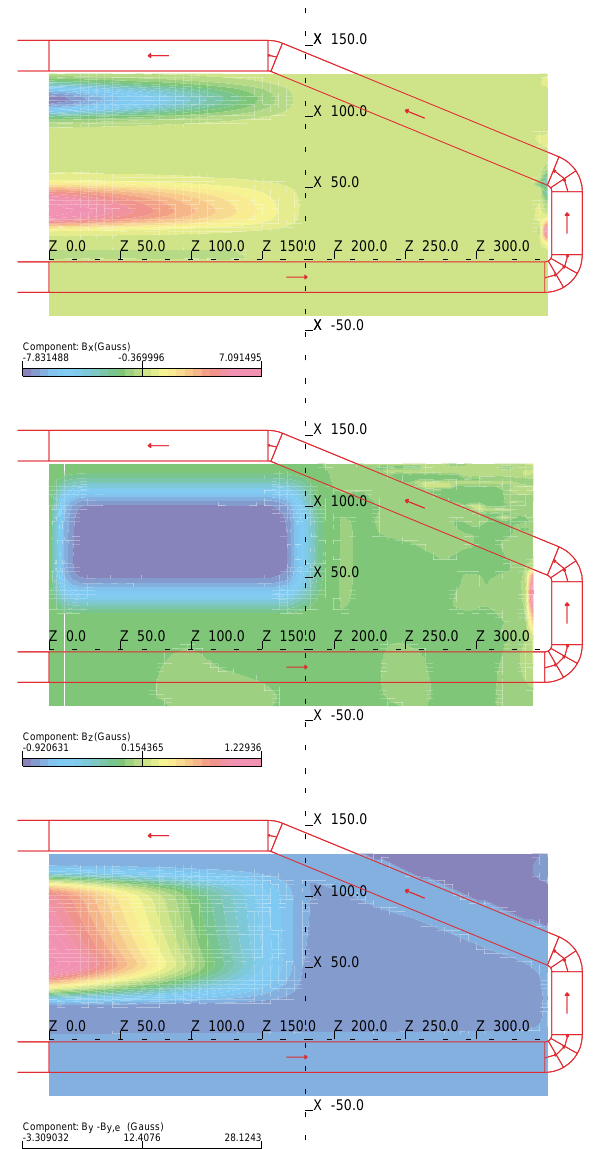
FIG. 2. (Color) Simulated field errors B x , B z , and B y 2 B y , e in the median plane of a 90 ± HDSM bending magnet with a slightly misaligned upper yoke.